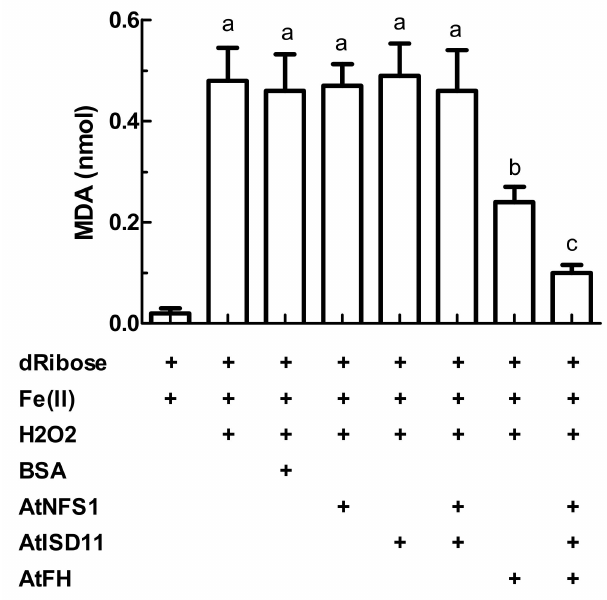
Figure 5. Oxidative degradation assays. Production of malondialdehyde from dRibose, Fe(II), and H 2 O 2 in the absence or presence of the recombinant proteins AtFH, AtNFS1, and AtISD11 or bovine serum albumin (BSA). Letters indicate significant di ff erences ( p <